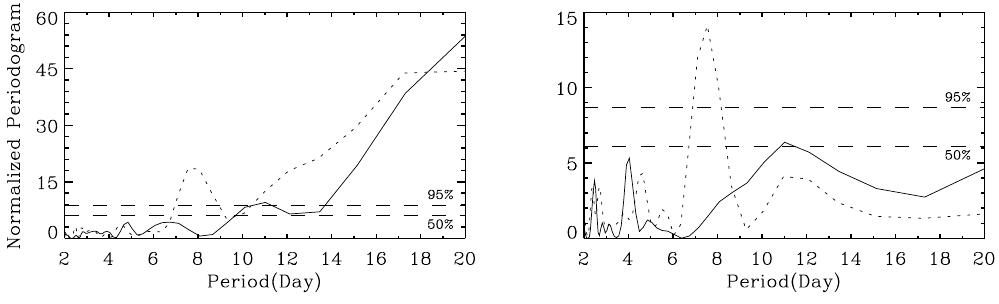
Fig. 19. Normalized Lomb-Scargle periodograms of the magnitude (left) and height (right) of the tropopause in August 2006 (solid) and January 2007 (dotted). The dashed horizontal lines denote the confidence levels of 95% and